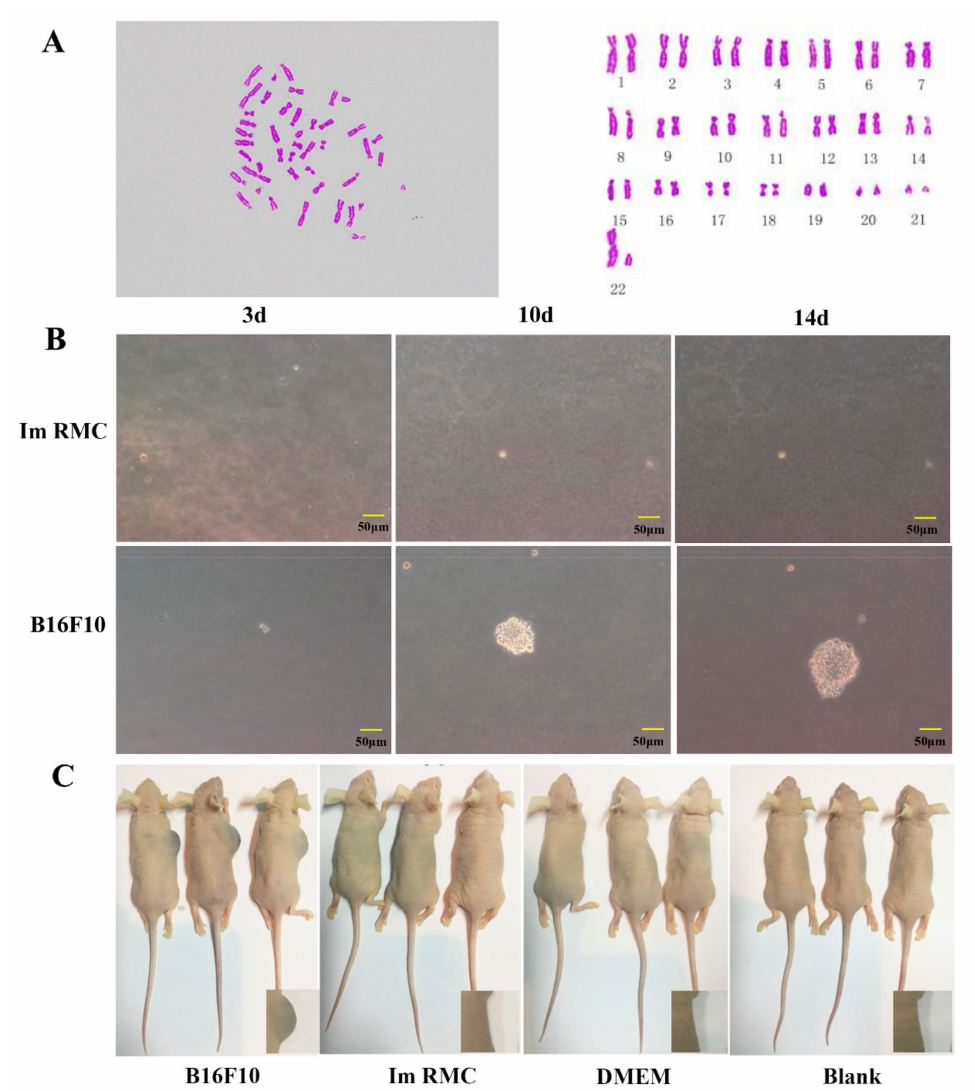
Figure 4. Malignant transformation of immortalized melanocytes. ( A ) Karyotype analysis of immortalized melanocytes (1000 × ). ( B ) Soft agar colony assays for the analysis of the malignant transformation of immortalized cells (200 × ). B16F10 was used as a positive control. ( C ) Tumor induction in nude mice. B16F10 was used as a positive control. Dulbecco’s Modified Eagle Medium (DMEM) medium was used as a negative control. Blank indicates no